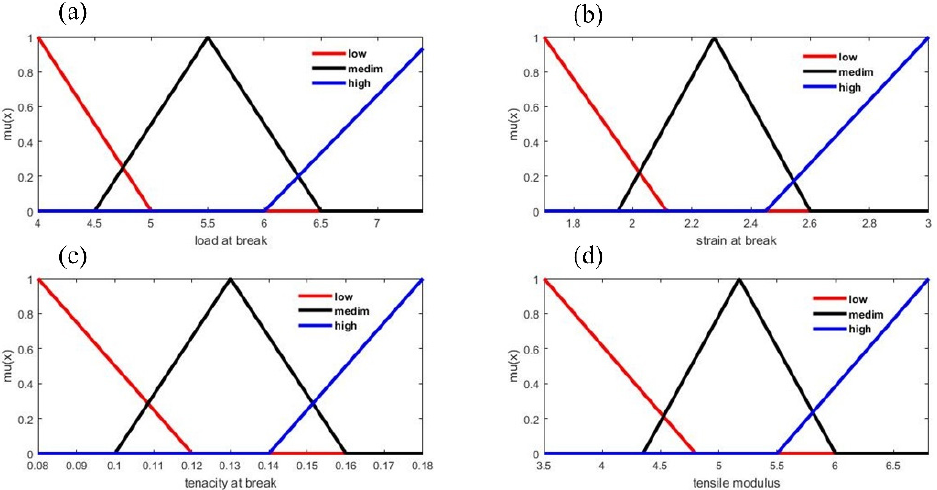
Figure 2. Triangular membership function for the input parameters; ( a ) load at break, ( b ) strain at break, ( c ) tenacity at break, and ( d ) tensile modulus.